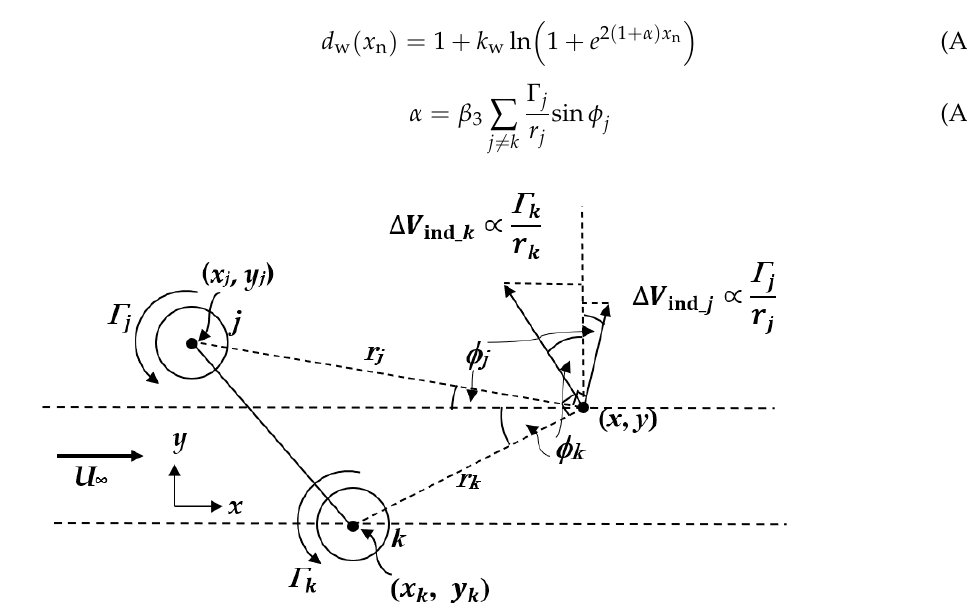
Figure A3. Schematic image of a pair of rotors and the induced velocity. Angle 𝜙 (cid:3037) is defined at an arbitrary point P:( x , y ) when seeing the direction of the center position of a rotor on the basis of the upstream direction.